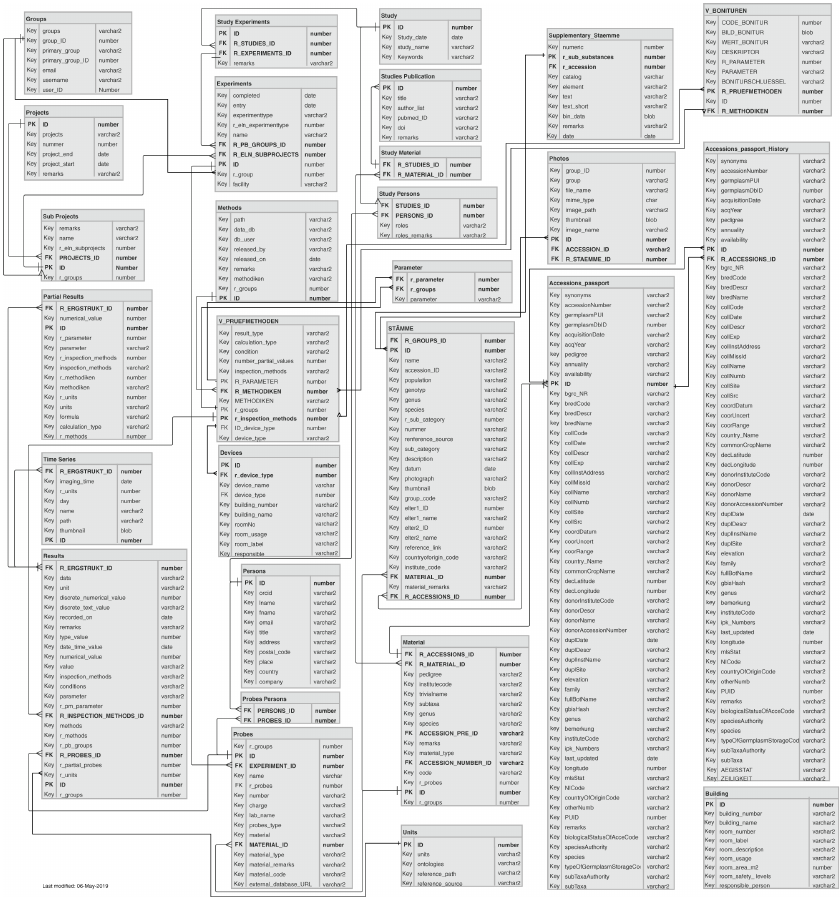
Figure 2: Generic ER schema of the LIMS database backend.